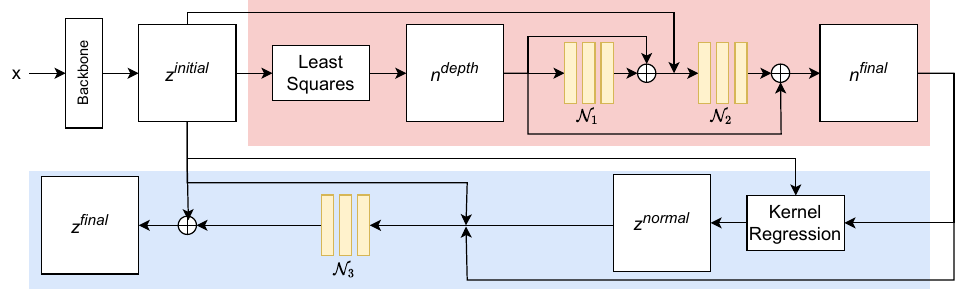
Figure 1. The proposed network architecture. Red—normal refinement module; blue—depth- refinement module; yellow—CNNs with learnable